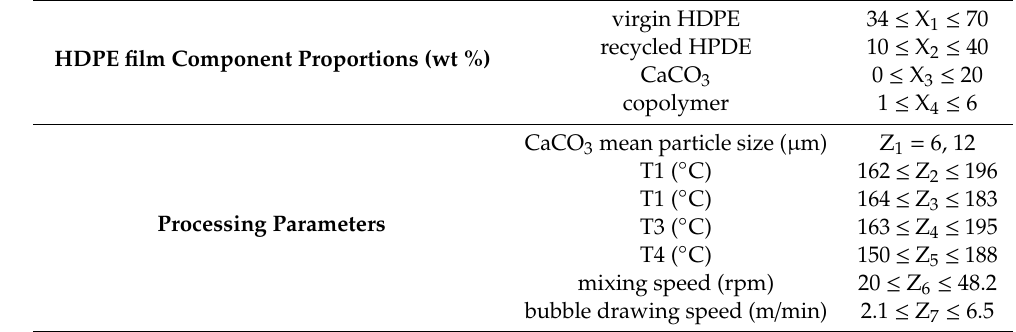
Table 1. Constraints on virgin high-density polyethylene (HDPE) film component proportions and processing